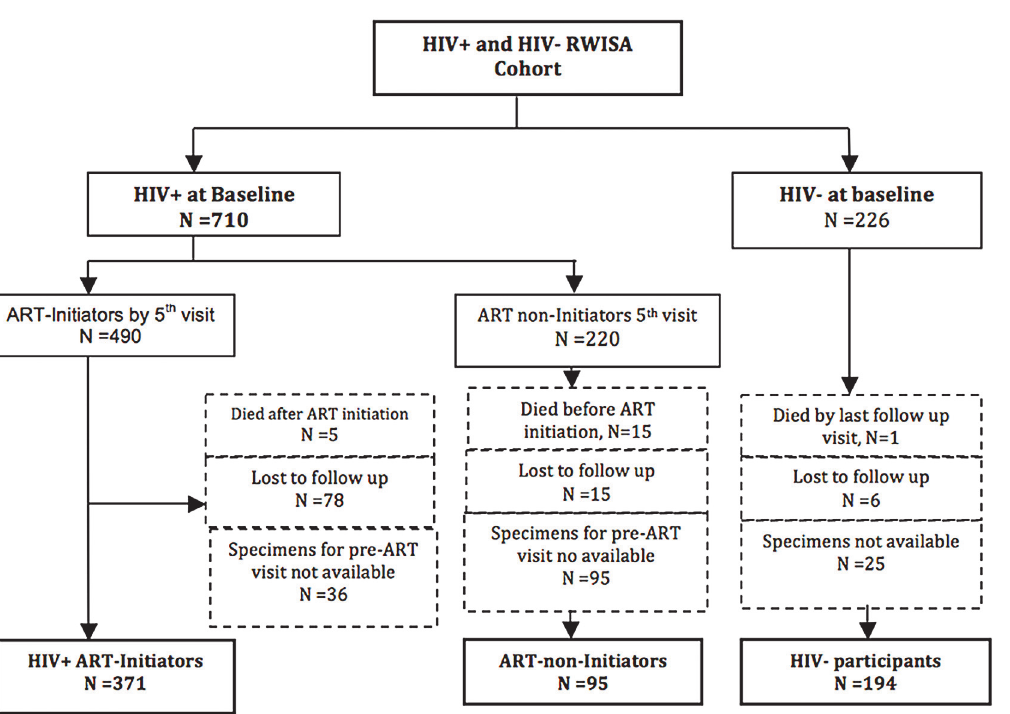
Fig 1. Flow Diagram RWISA longitudinal insulin resistance study; RWISA, Rwanda Women ’ s Interassociation Study Assessment; HIV, Human immunodeficiency virus; ART, antiretroviral therapy; HIV+, HIV-infected; HIV-, HIV-uninfected.